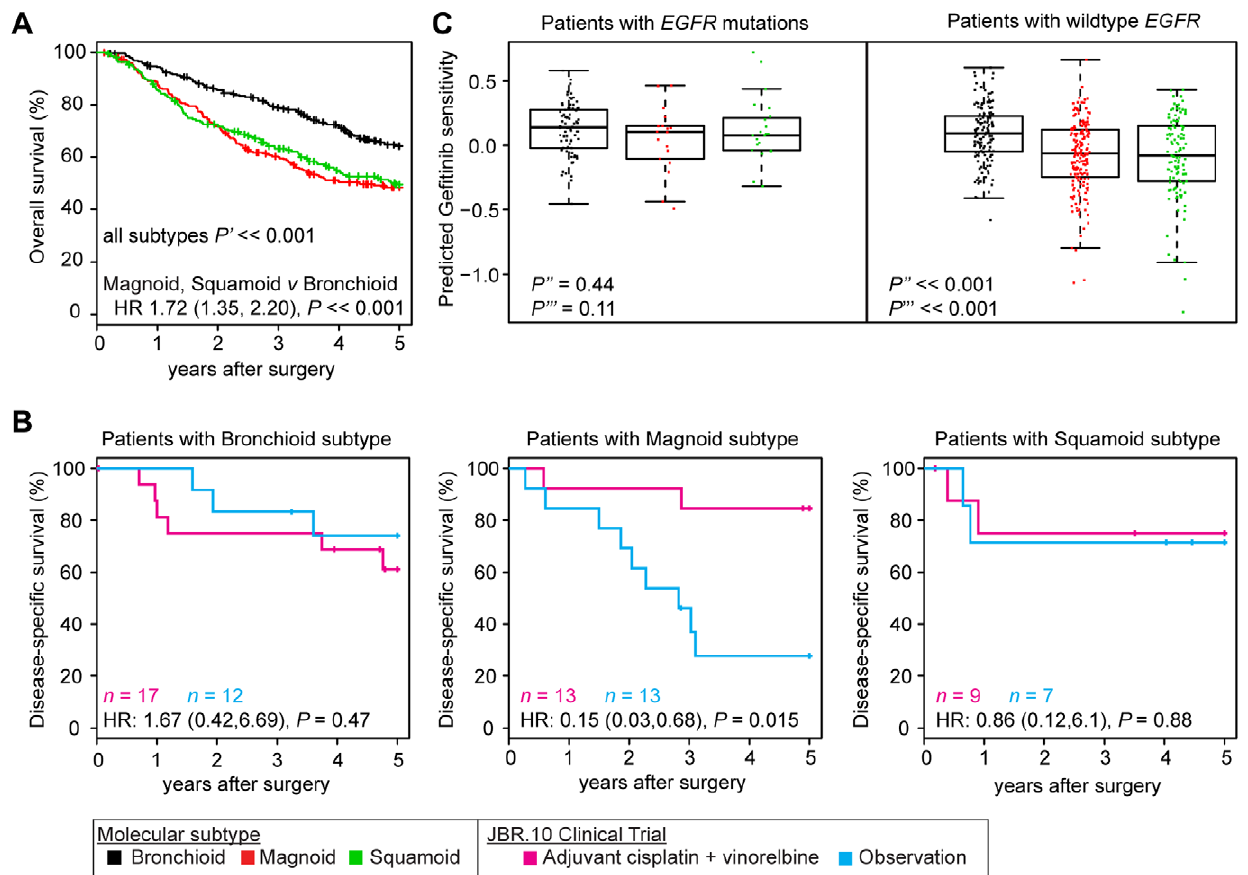
Figure 6. Patient outcomes compared among molecular subtypes. Overall survival is displayed for patients from cohorts with survival follow- up (Bhattacharjee et al., Chitale et al., Shedden et al., Tomida et al., UNC, and Zhu et al.; n =807) (A). Overall survival among the three subtypes was compared by a log-rank test (two-sided P 9 ). Patient disease-specific-survival from the Zhu et al. JBR.10 trial 25] is displayed by treatment type, for each subtype (B). Hazard ratios (HR) compare treatment to observation. Gefitinib sensitivity scores, derived from a cell line expression signature, are displayed for all patients with EGFR mutation status (Bhattacharjee et al., Ding et al., Chitale et al., Tomida et al., UNC; n =561) (C). Predicted gefitinib sensitivities were compared by Kruskal-Wallis tests among the three subtypes in the EGFR mutation group and separately for the EGFR wild type group (two-sided P 0 ). Wilcoxon rank-sum tests evaluated the hypothesis that Bronchioid tumors have not greater scores than Squamoid and Magnoid tumors within each EGFR mutation group separately (one-sided P 09 ).